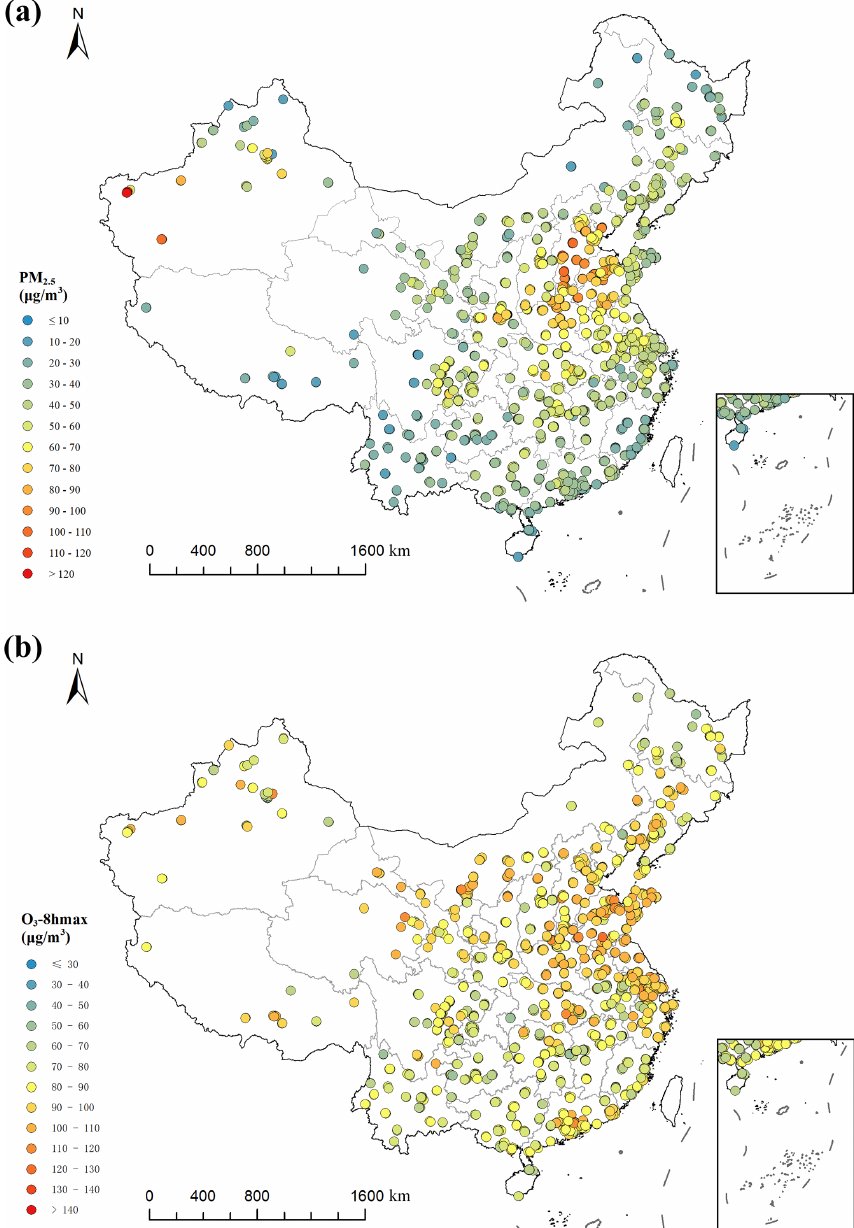
Figure 1. Station distribution in China and average ground monitoring concentration based on the available data of PM 2 . 5 (a) and O 3 - 8hmax (b) from 2013 to